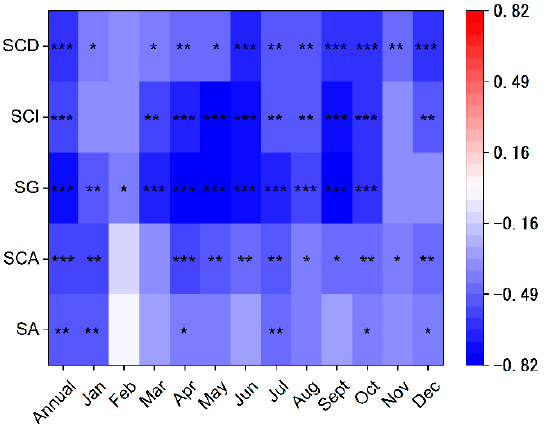
Figure 9. Pearson correlation coefficients between the NDVI and the sediment characteristics. SA is the annual sediment discharge, SCA is the annual suspended sediment concentration, SG is the Gini concentration index for sediment, SCI is the concentration index for sediment, and SCD is the concentration degree for sediment. * Significance at 10% level; ** significance at 5% level; *** significance at 1% level.